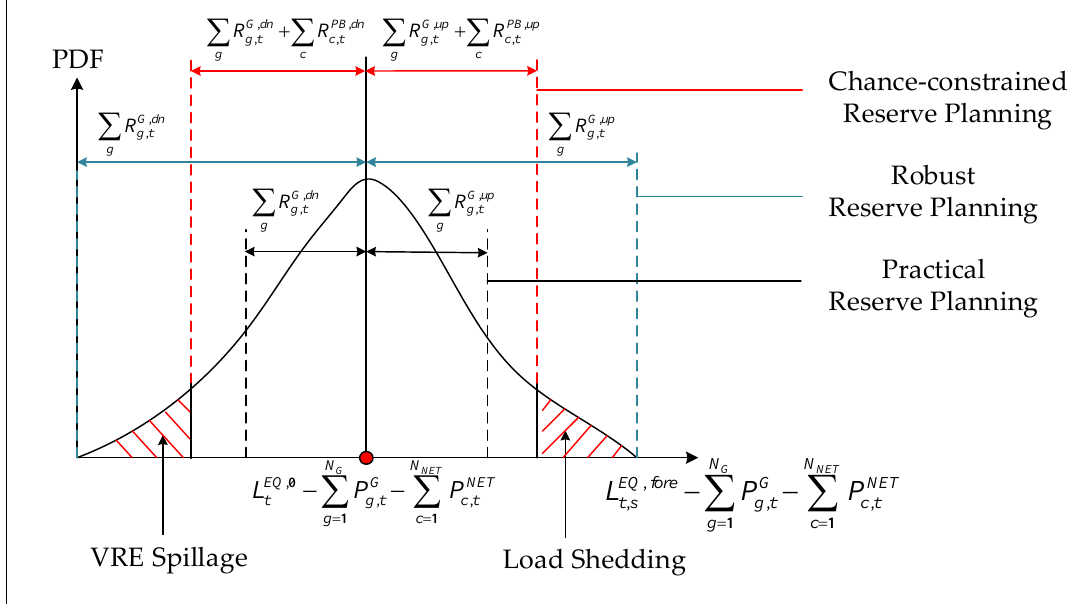
Figure 3. Load shedding and renewable energy spillage.